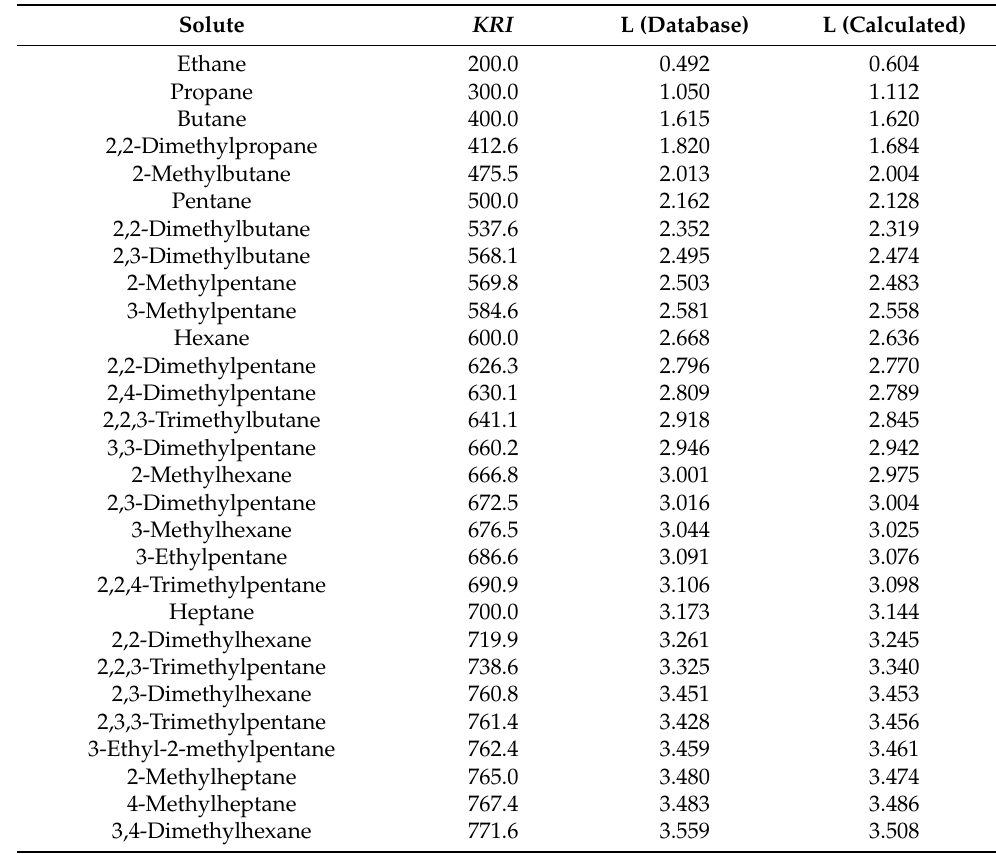
Table 1. Kov á ts Gas Chromatographic Retention Indices, KRI and Abraham Model L -Solute Descrip- tor Values for Linear Alkanes, and Methyl- and Ethyl-branched Alkanes Eluted from a Squalane Stationary Phase Liquid